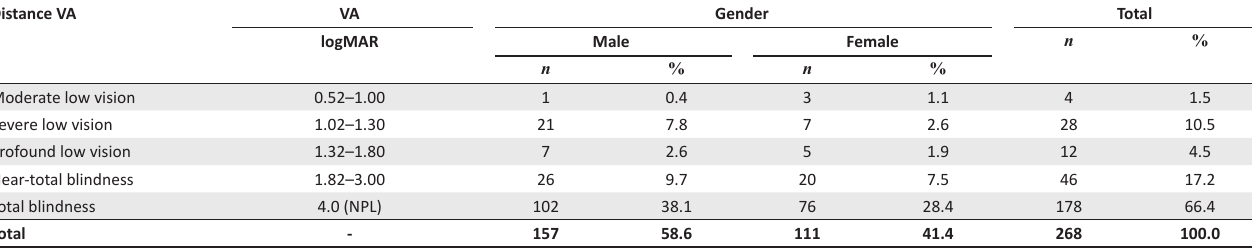
TABLE 3: Classification of low vision and blindness. Distance